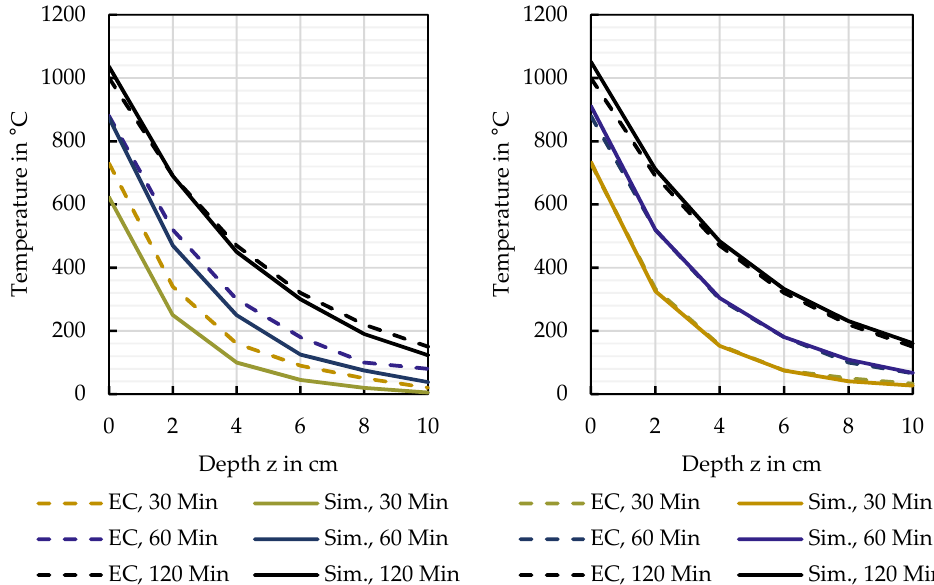
Figure 3. Calculated values of the temperature-dependent thermal material properties of steel (re- produced from [10]).